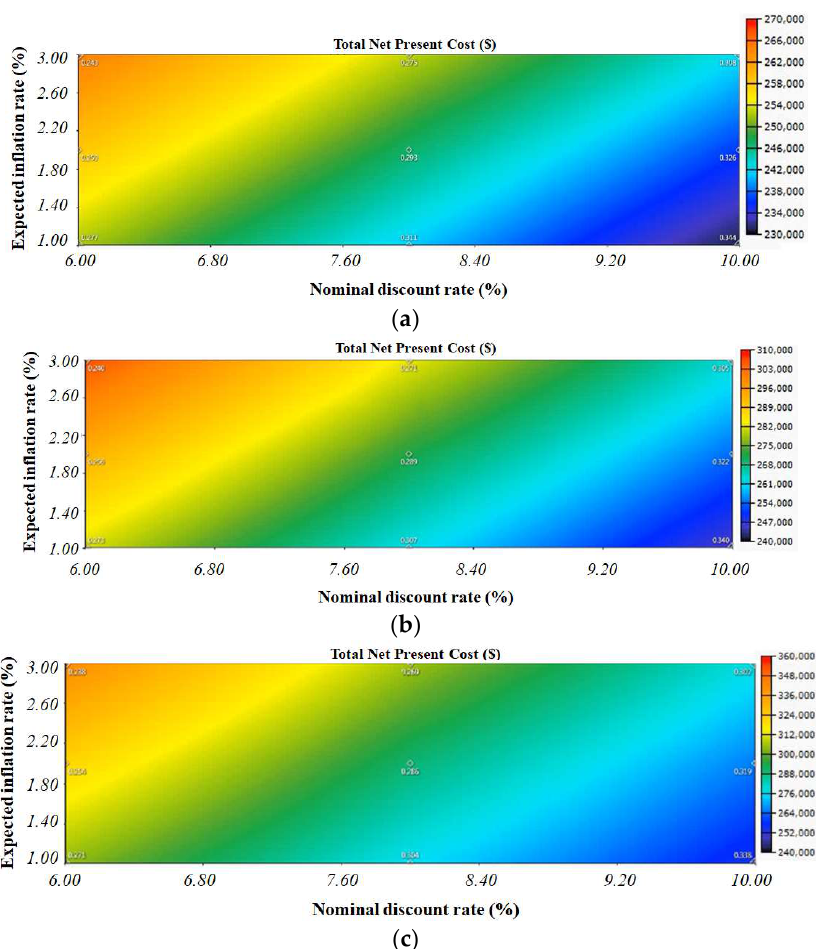
Figure 22. Variation in NPC as per inflation rate and discount rate with project lifetime of ( a ) 20 years, ( b ) 25 years, and ( c ) 30